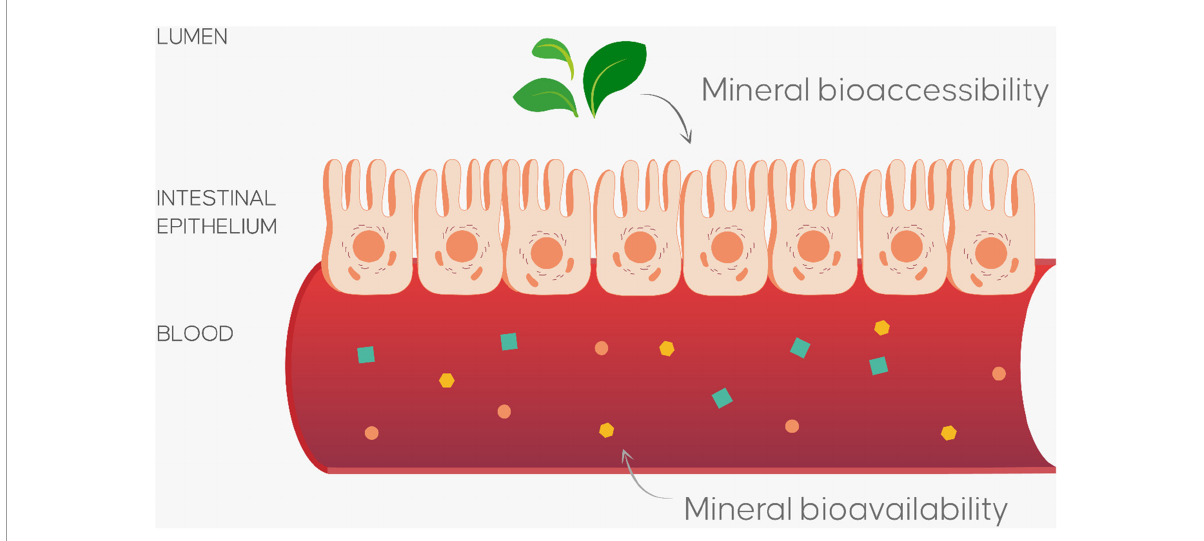
FIGURE3 In vitro model for evaluate bioaccessibility (percentage of nutrient release from food matrix during gastro-intestinal digestion process) and bioavailability (percentage of nutrient adsorbed in intestinal tract after gastro-intestinal digestion process) of nutrients and/or bioactive